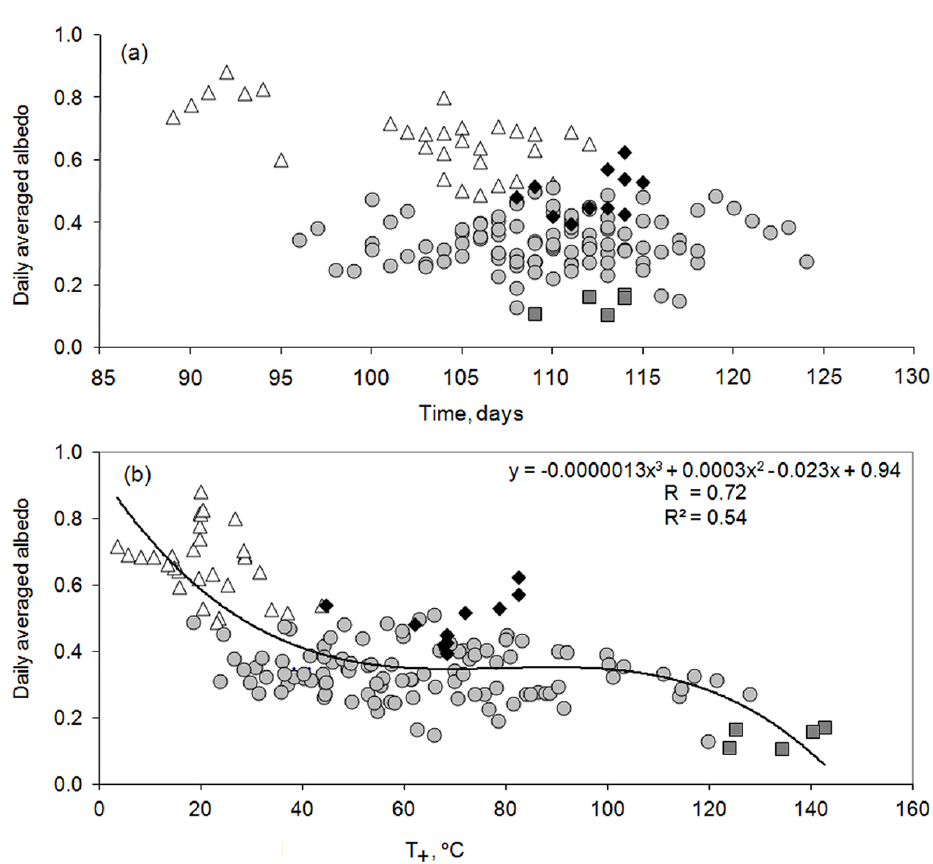
Figure 6. Temporal variability of solar zenith angle on April 20, 1999 (blue line), downwelling irradiance (dotted lines) and albedo of congelation ice (bold lines) during clear April 20, 1999 (red) and cloudy April 22, 1999 (green).